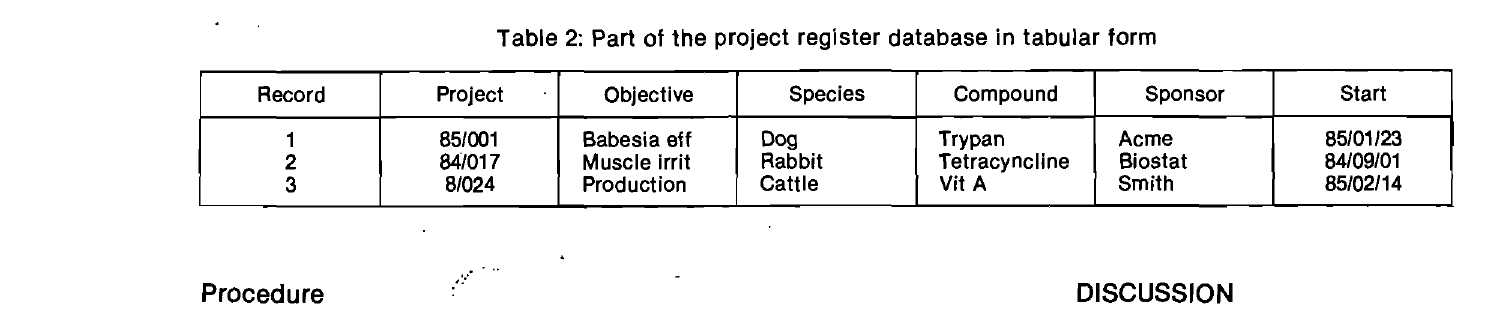
Table 3: One record from the project register database in interim report form